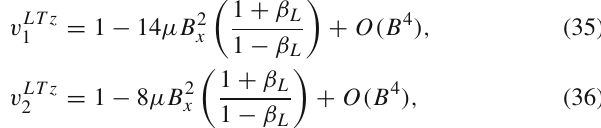
electric uniform background v 2 reaches lower values than v 2 . When ( E / E ) 2 = ( E / E ) 2 = 1 the velocities are the same (thick line over- x z 2 laps dashed